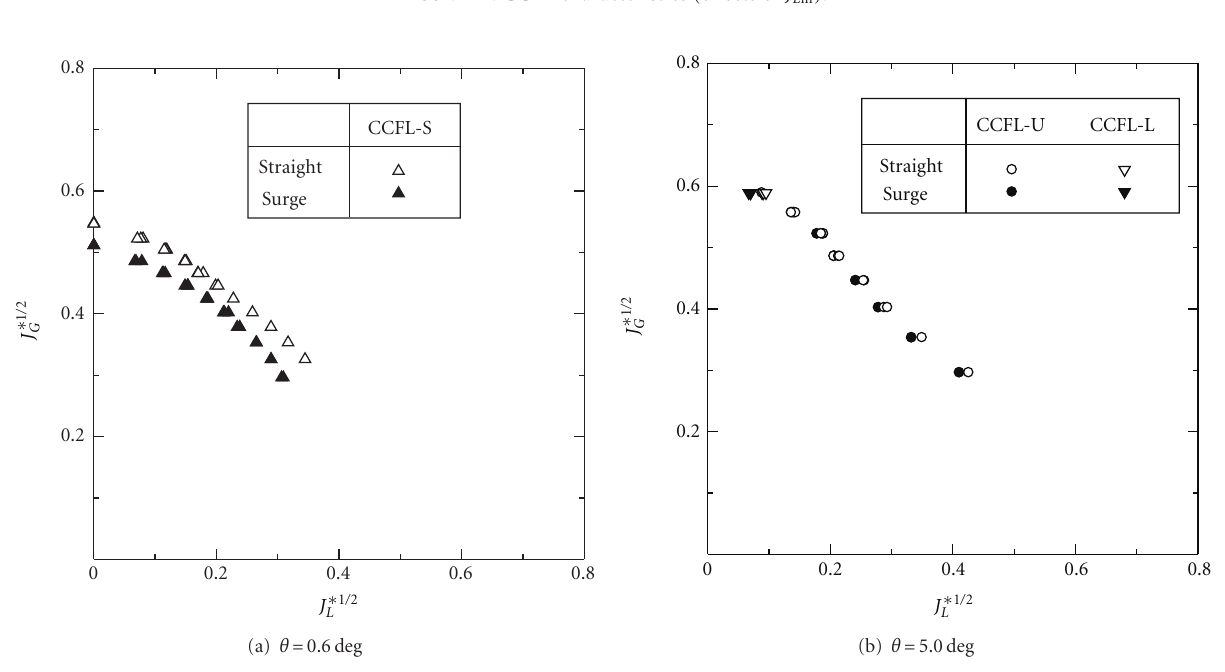
Figure 12: CCFL characteristics (e ff ects of J L in ).